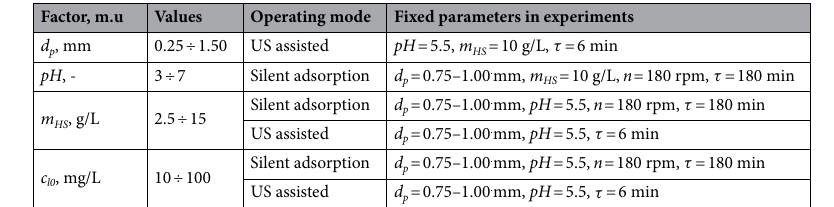
Table 1. Experimental matrix for process factors in biosorption